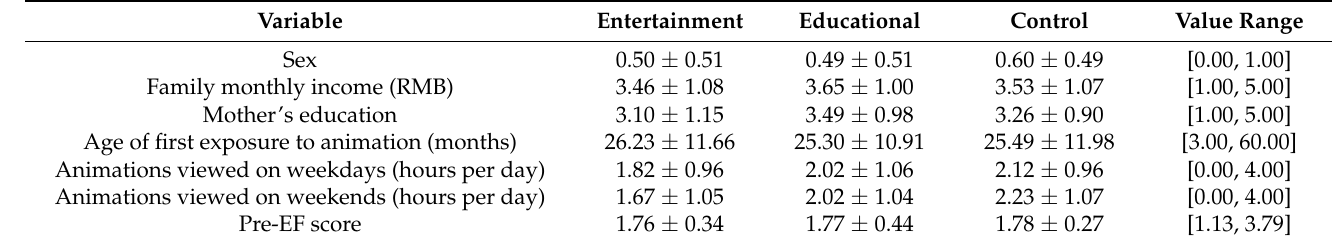
Table 1. Descriptive statistics of the three groups of children for each variable.